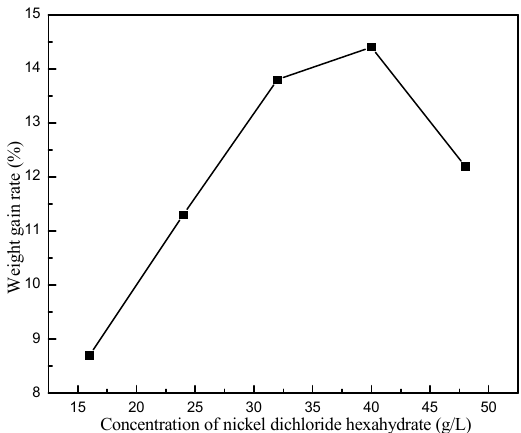
Figure 8. Effect of NiCl 2 · 6H 2 O concentration on the weight gain rate.